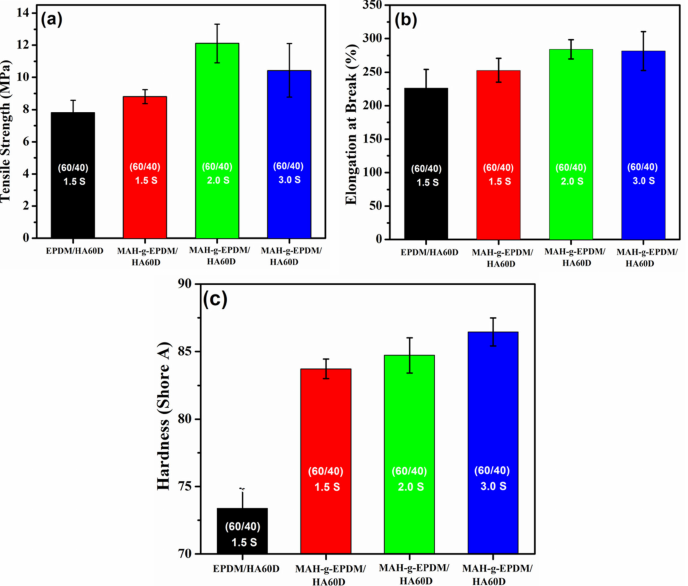
Figure 4. The mechanical properties of EPDM- g -MAH/HAD60 TPVs with different sulfur loadings: ( a ) Tensile strength, ( b ) Elongation at break and ( c ) Hardness